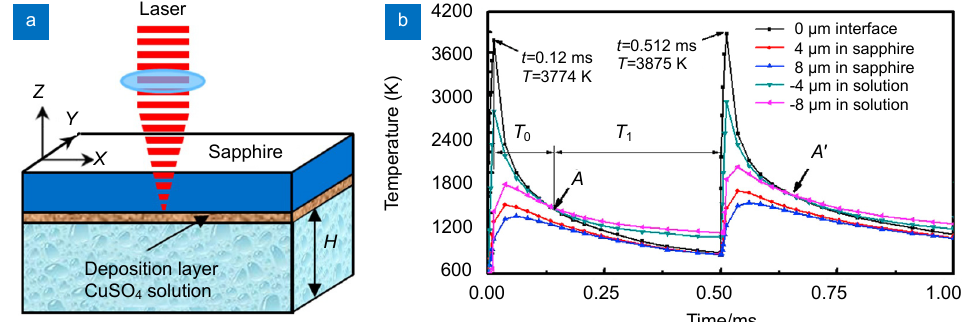
Fig. 5 | ( a ) Schematic diagram of three-dimensional model. ( b ) Temperature variation of different Z positions. Figure reprinted with permission from ref. 57 , Elsevier